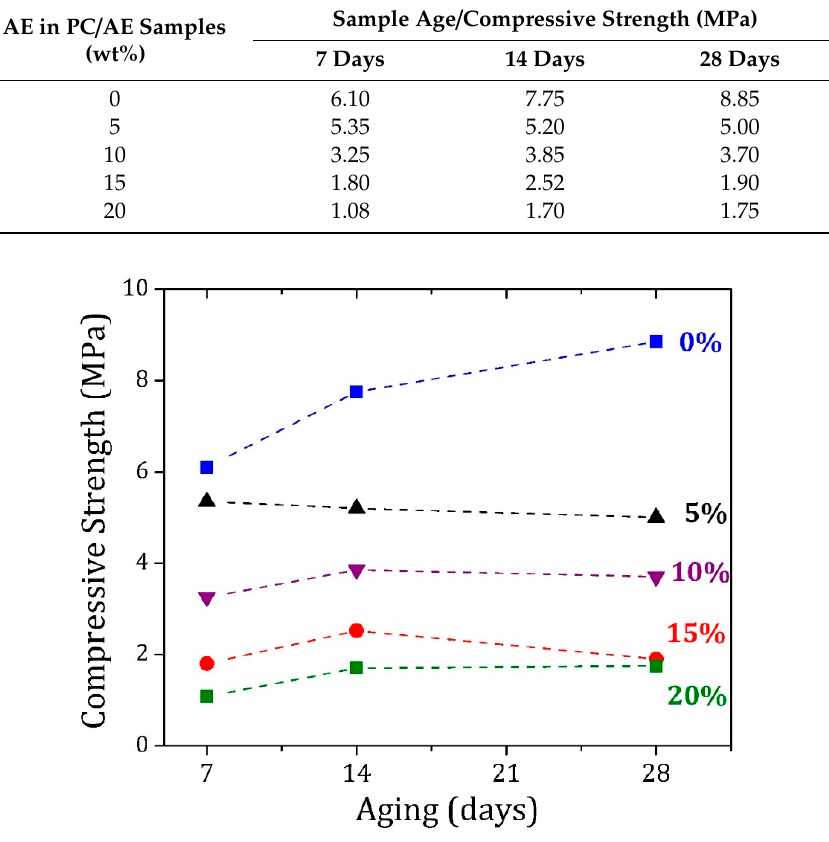
Table 2. Compressive strength of the PC and PC / AE composites at 7, 14, and 28 d of curing.